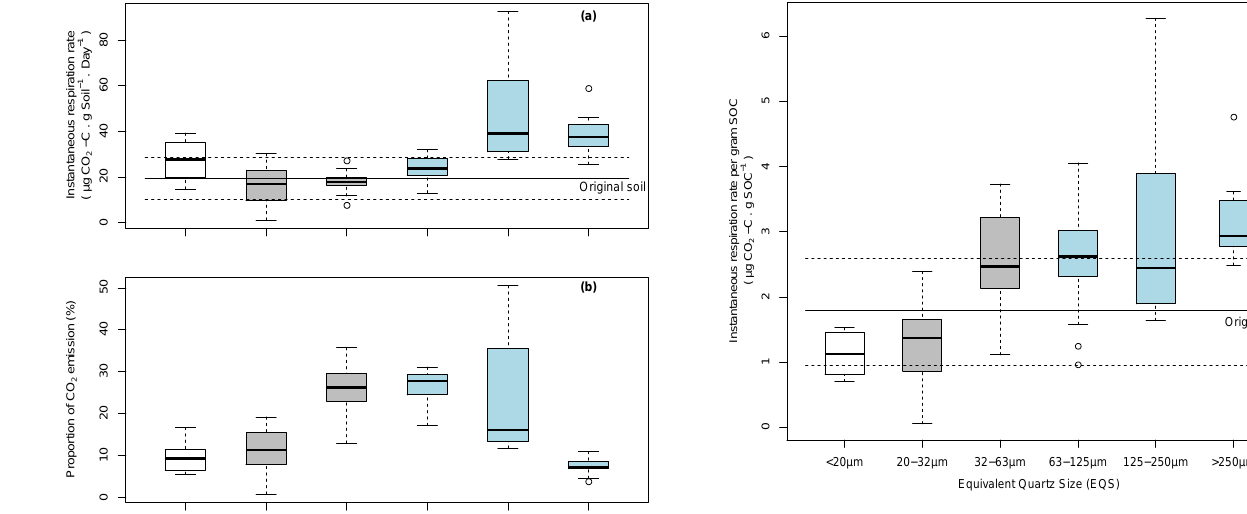
Figure 5. The distribution of instantaneous respiration rate per gram of soil organic carbon (SOC) in different Equivalent Quartz Size (EQS) classes of the sediment. The bold and dashed lines denote the average and standard deviation of instantaneous respiration rate per gram SOC of the original soil. Colors of the boxes correspond to the likely fate of each fraction after erosion. See Sect. 4.1 and Fig. 6 for definitions and explanation of the three manners of likely fate. Bars in boxes represent median values. Whiskers indicate the lowest datum within 1.5 interquartile range of the lower quartile, and the highest datum within 1.5 interquartile range of the upper quartile ( n =